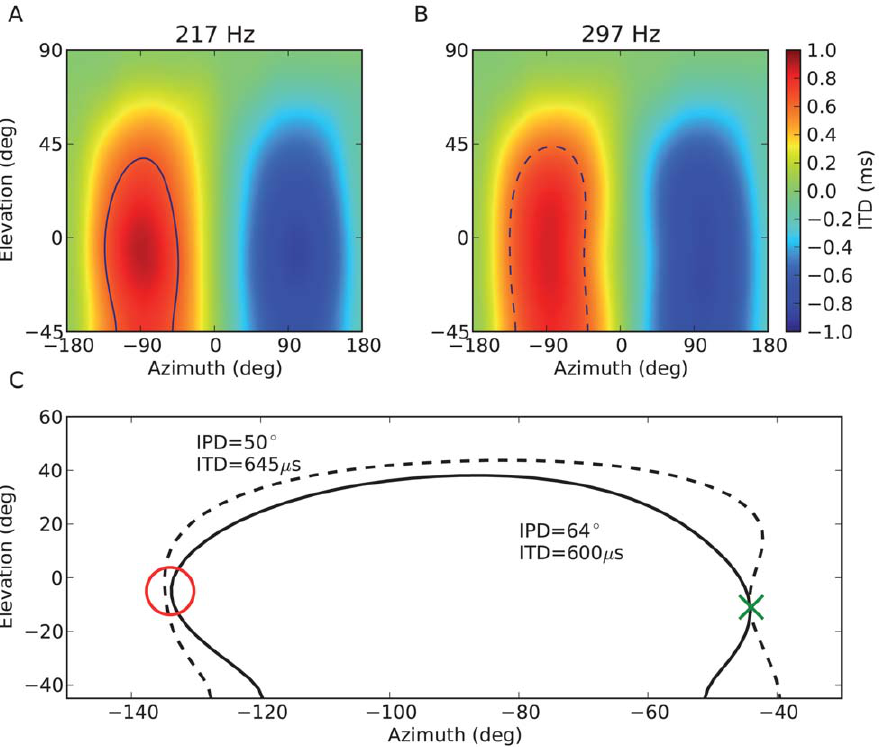
Figure 7. Illlustration of how the model can estimate both azimuth and elevation. (A) ITD measured at 217 Hz as a function of source location. When the sound is presented at azimuth 2 45 u and elevation 2 10 u , the ITD is consistent with all locations shown by the solid curve. For a spherical head, this curve corresponds to the ‘‘cone of confusion’’. (B) ITD measured at 297 Hz vs. source location. The pattern is similar but quantitatively different from ITDs measured at 217 Hz (A), because sound diffraction makes ITDs frequency-dependent [21]. The ITD at location ( 2 45 u , 2 10 u ) is consistent with all locations shown by the dashed curve. (C) When the sound includes frequency components at 217 Hz and 297 Hz and ITDs can be measured in both channels, source location is unambiguously signaled by the intersection of the two level lines (green cross), corresponding to the ITD measured at the two frequencies. The red circle shows that this intersection resolves a potential front-back confusion.